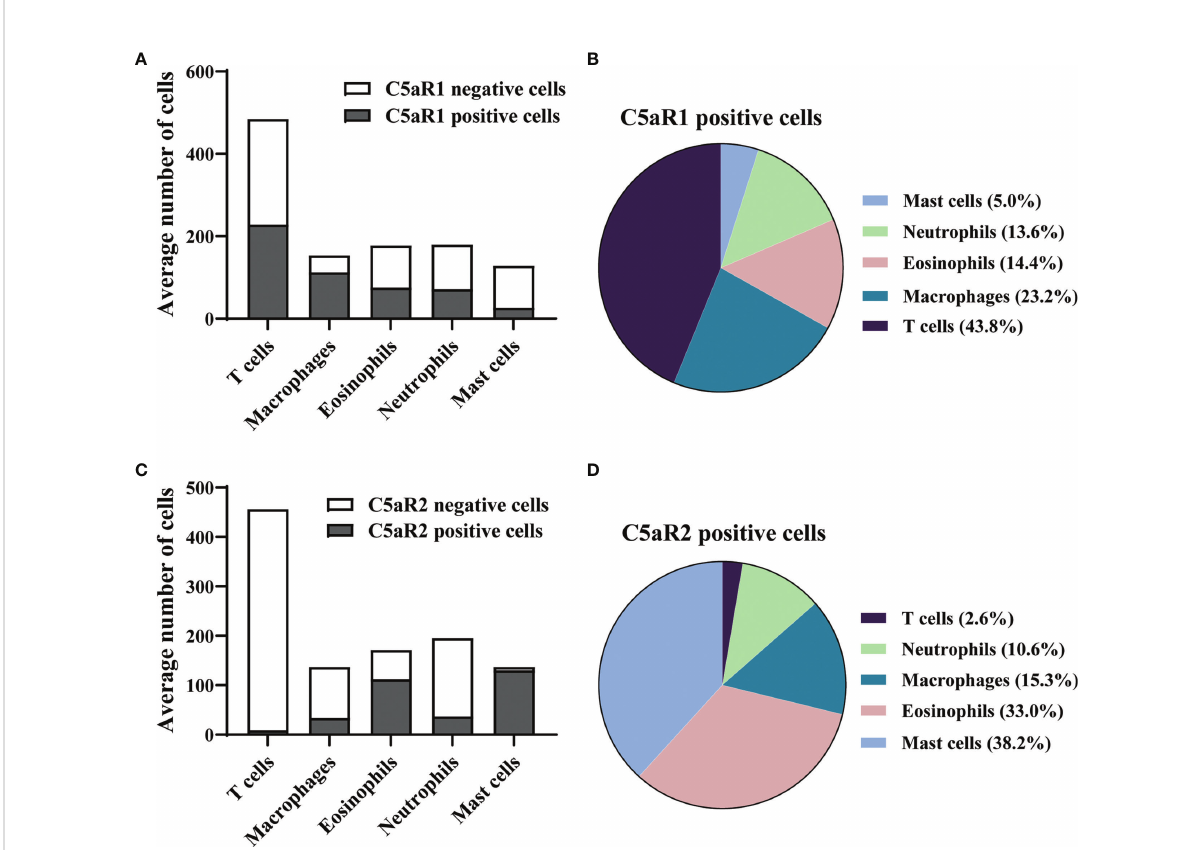
FIGURE 3 In early skin lesion of bullous pemphigoid (BP), T cells are the main source of C5aR1, while C5aR2 is predominantly expressed on mast cells and eosinophils. (A, C) Quanti fi cation of C5aR1- (A) and C5aR2-expressing cells (C) in perilesional BP skin samples (n=9) as determined by IF staining detailed in Figure 2. (B, D) Pie charts show the percentage of C5aR1- (B) and C5aR2-expressing cells (D) in relation to all in fl ammatory cell subsets in perilesional skin of BP